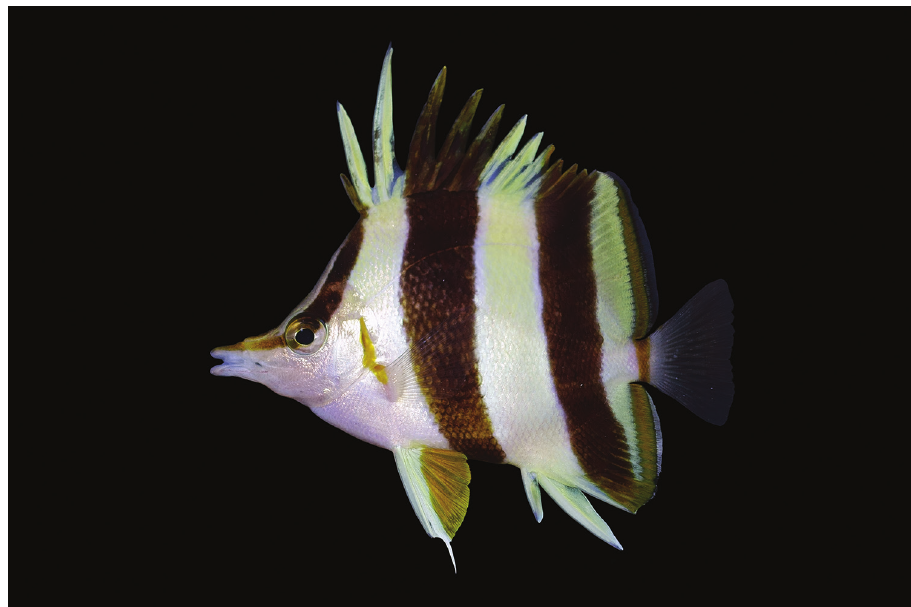
Figure 1. Holotype of Prognathodes basabei (BPBM 41290), collected at a depth of 61 m off Pearl and Hermes Atoll, Northwestern Hawaiian Islands. Photo by R. L.